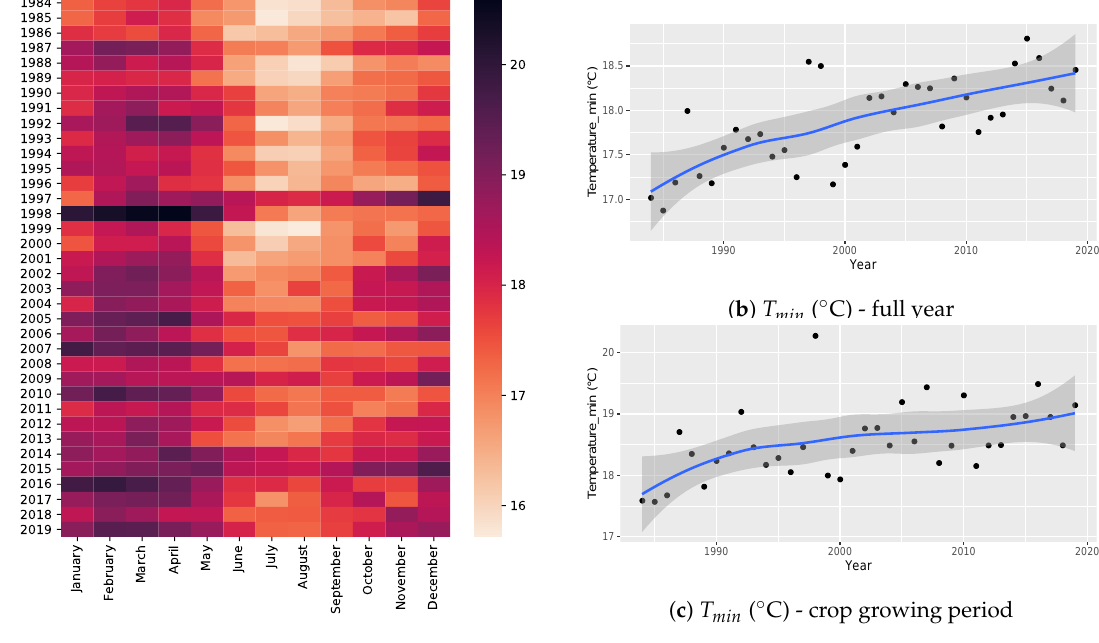
Figure A5. Time series of average minimum temperature ( ◦ C) in Los Rios from 1984 to 2019. ( a ) Heat-map of T min ( ◦ C) per each month and year. The color scale represents the temperature in ◦ C. ( b ) T min ( ◦ C) averaged during the full year. ( c ) T min ( ◦ C) averaged during the maize crop growing period in Ecuador (January–May). Each dot represents one record, the blue line shows the smoothed time series and the shaded area represents the 95% confidence